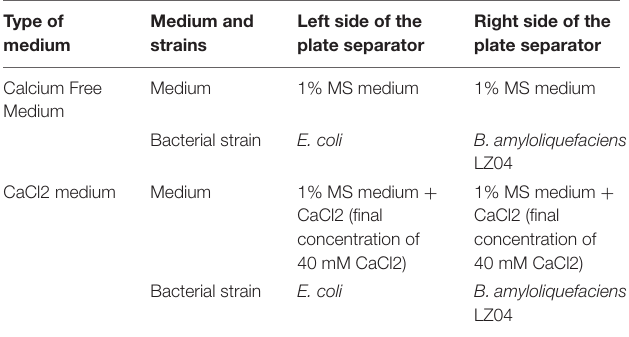
TABLE 1 | Summary of culture conditions indicating the type of media and strains culture in each side of plate separators. Type of